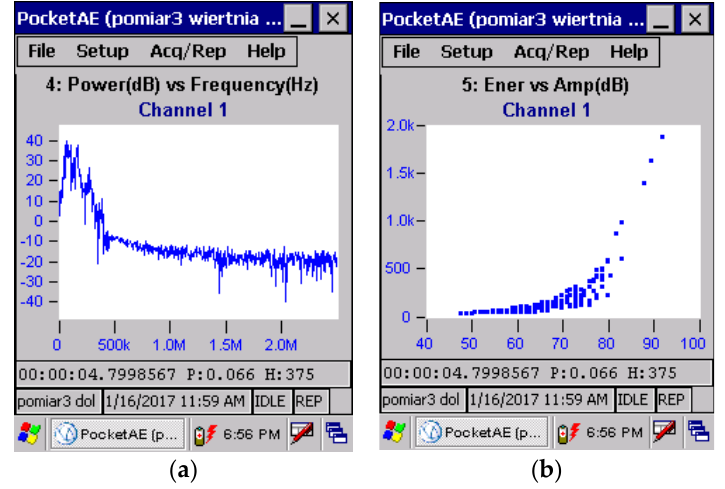
Figure 17. Analysis of AE signal power as a function of frequency ( a ) and energy amplitude of a signal ( b ) from a correctly working pump valve.